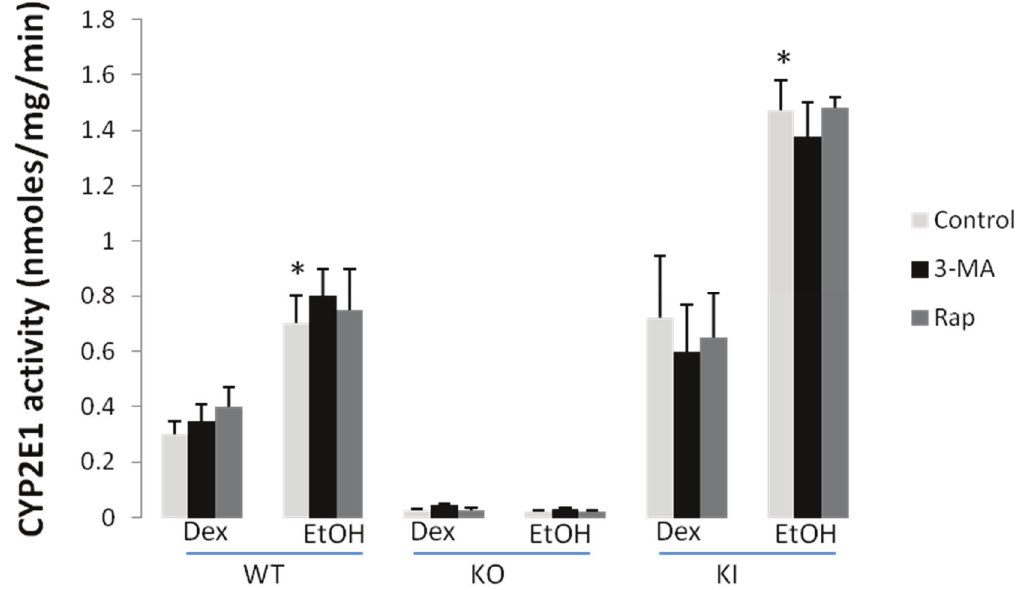
Figure 4. 3-MA and rapamycin administration do not modify CYP2E1 catalytic